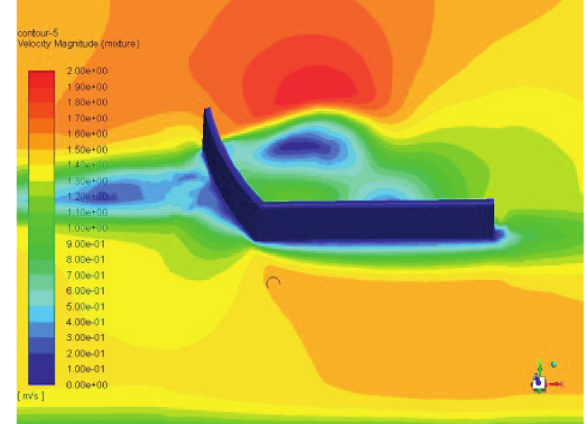
Figure 10: Velocity nephogram of 20.